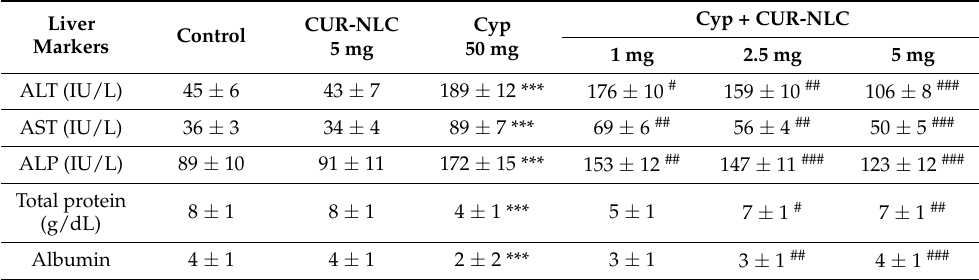
Table 1. Biochemical effects of CUR-NLC in serum of Cyp-induced hepatotoxicity in rats. Liver